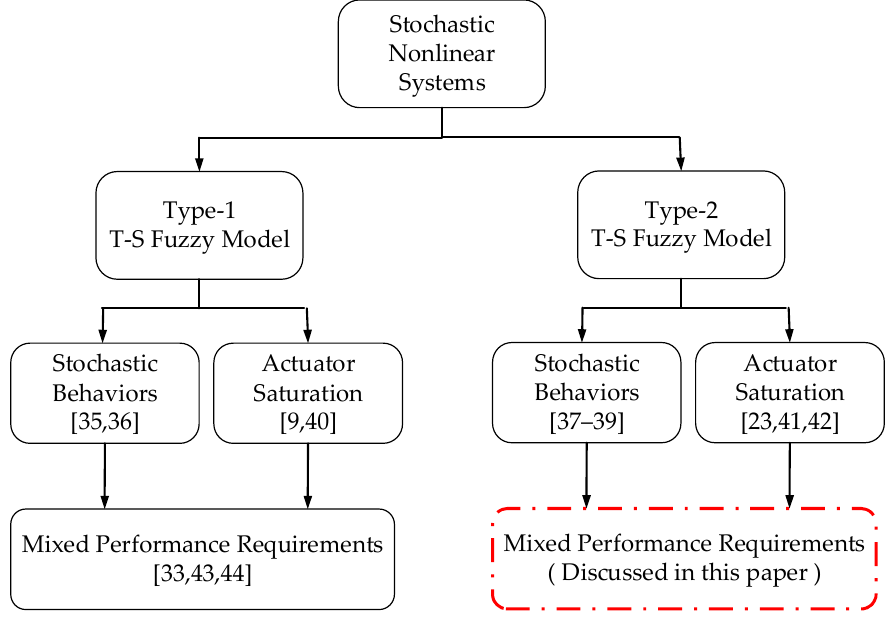
Figure 1. Motivation and purpose of this paper.